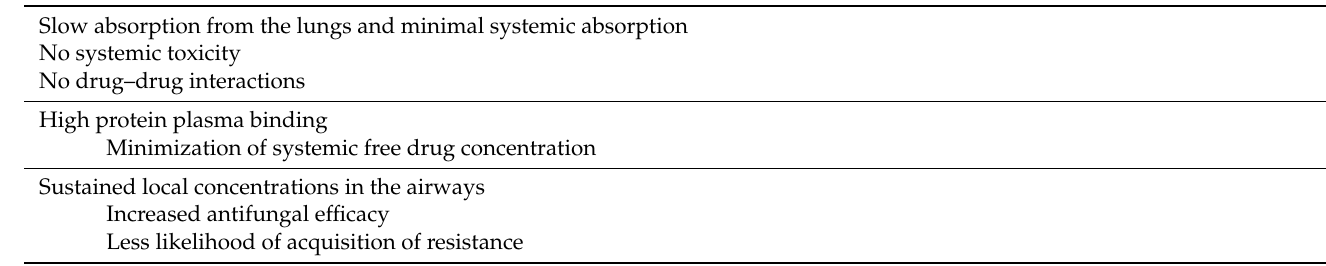
Table 4. Clinical characteristics of an ideal inhaled